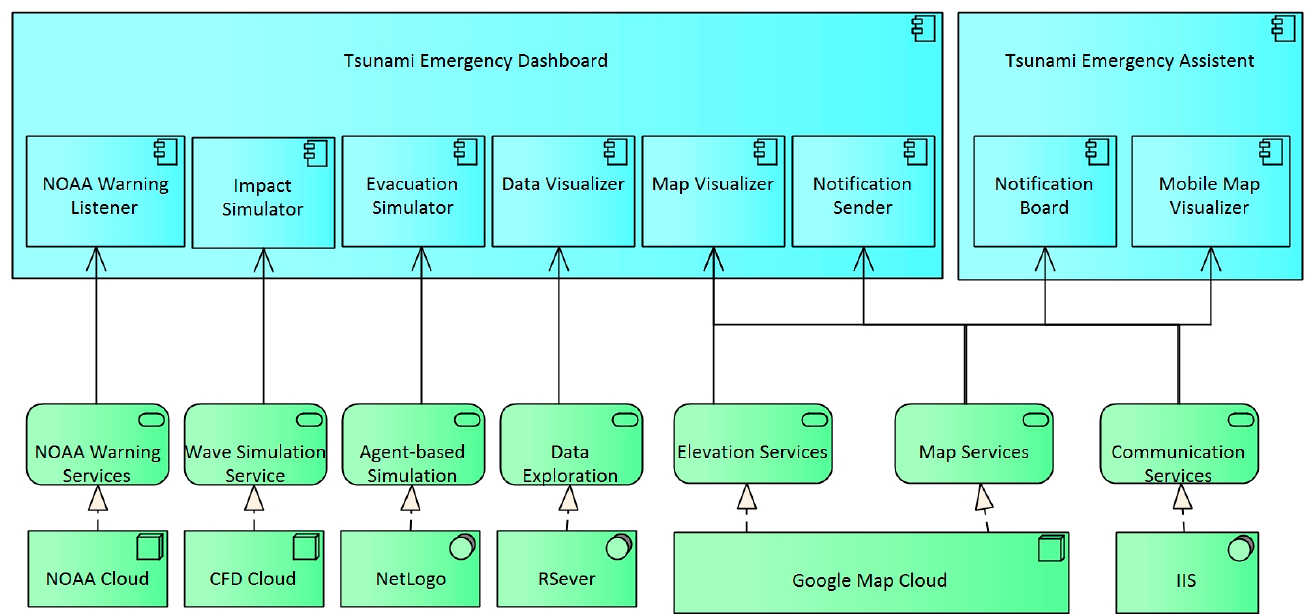
Figure 1. Solution architecture using ArchiMate specification. The blue colour denotes application layer elements. Green is for technology layer elements.